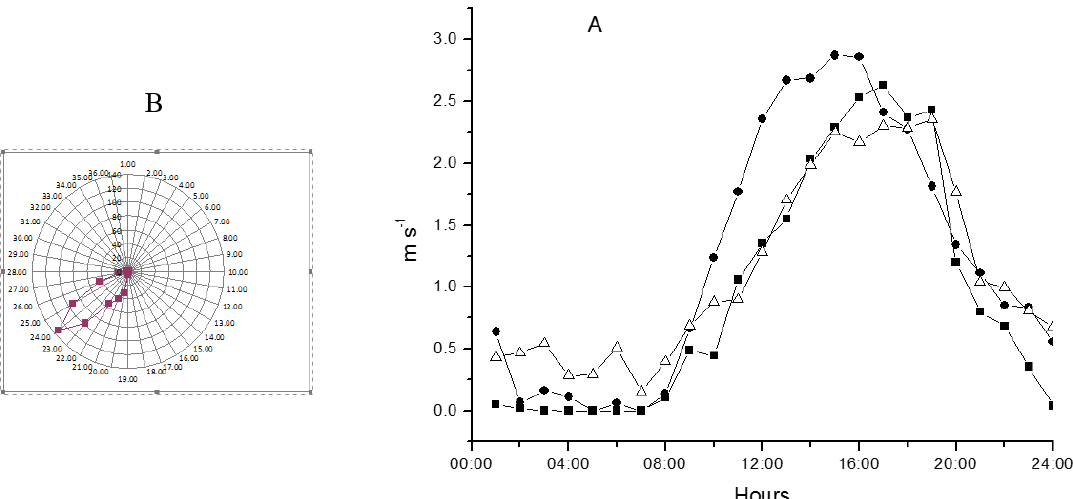
Figure 3. ( a ) Wind speed and wind in days with active fires (▪ January 8; ● January 4; and days without fires ∆; ( b ) Wind rose for 4 January, 14:00–24:00.